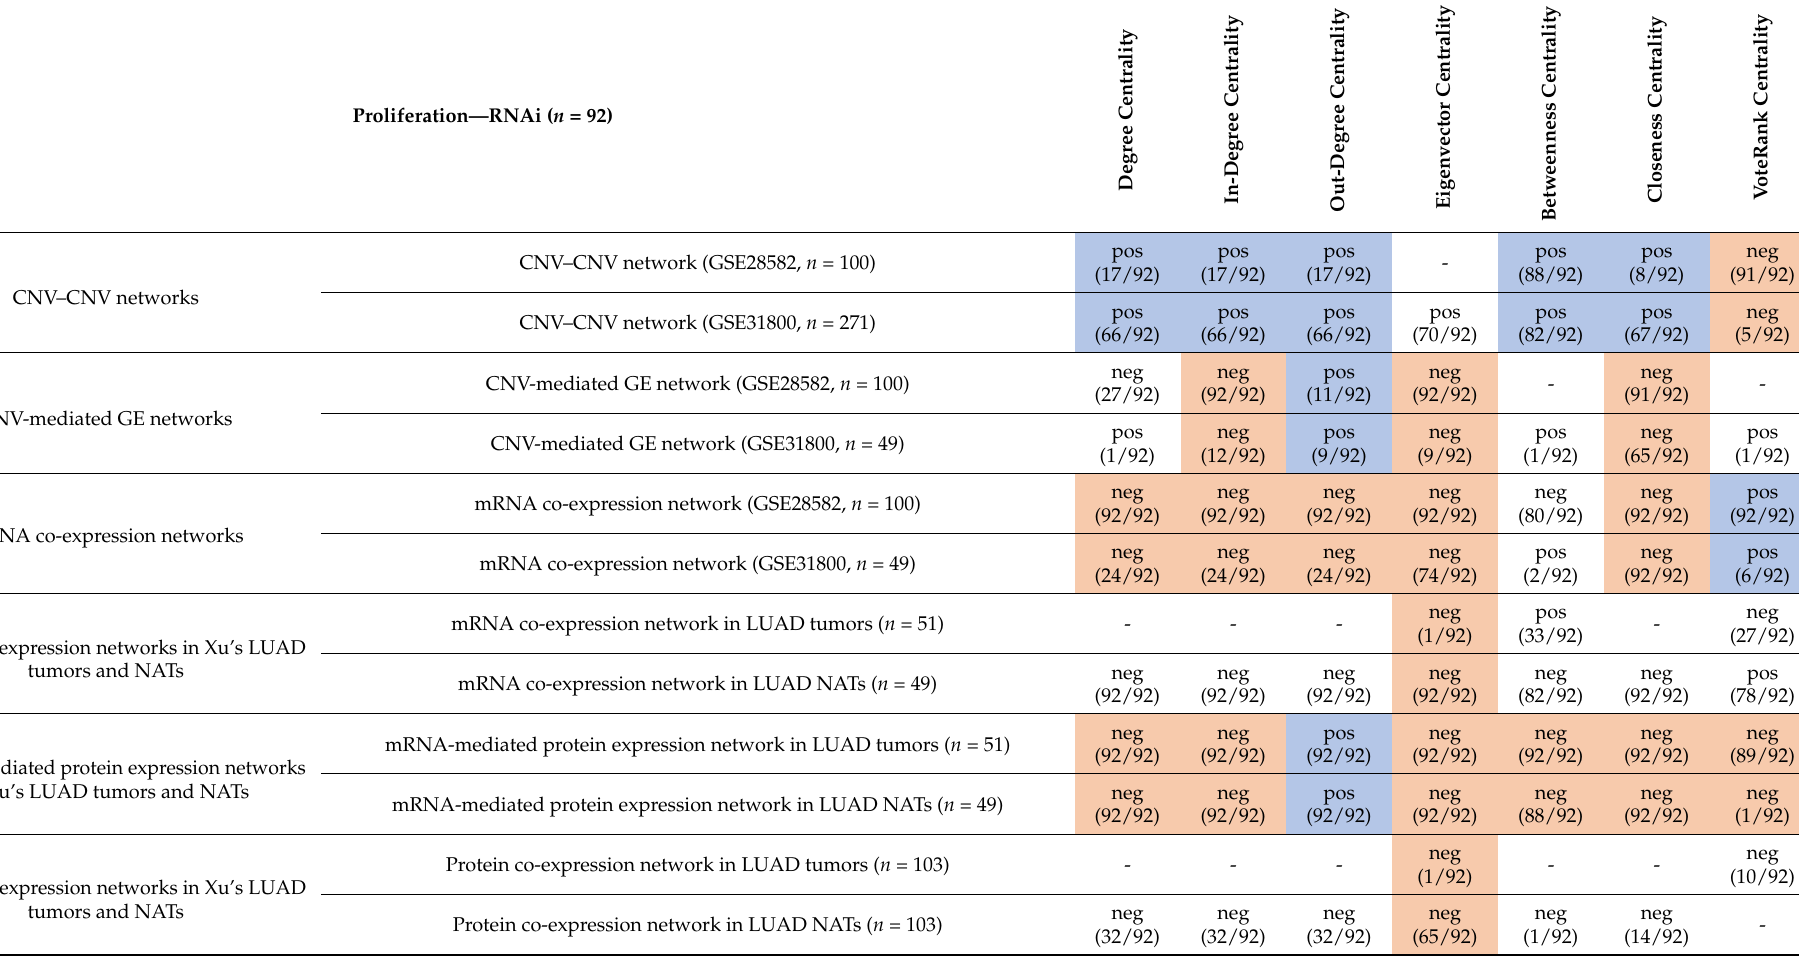
Table 5. Correlations of seven centrality metrics of selected networks with RNAi dependency scores. pos: Pearson’s correlation coefficient r > 0 and p < 0.05; neg: r < 0 and p < 0.05. The numbers in parentheses showed the number of significant NSCLC cell lines. The blue color indicates concordant positive correlations. The orange color indicates concordant negative